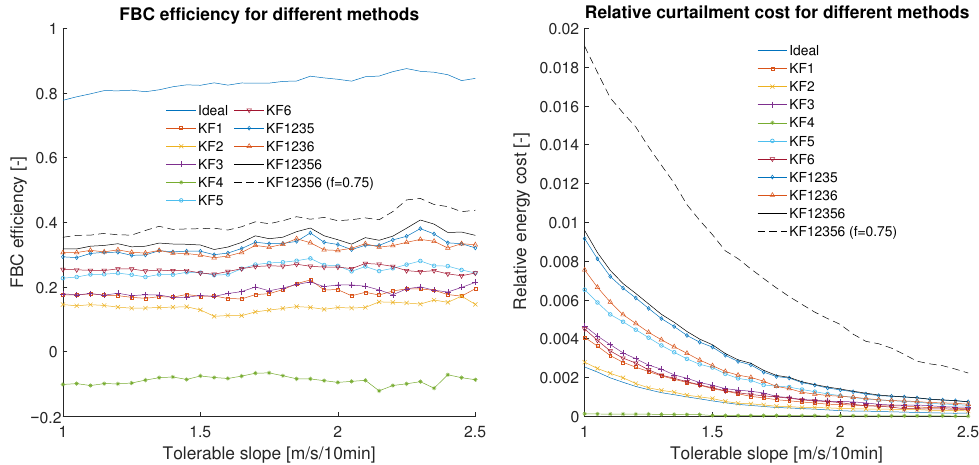
Figure 10. FBC results for all methods. Left: FBC efficiency, right: curtailment